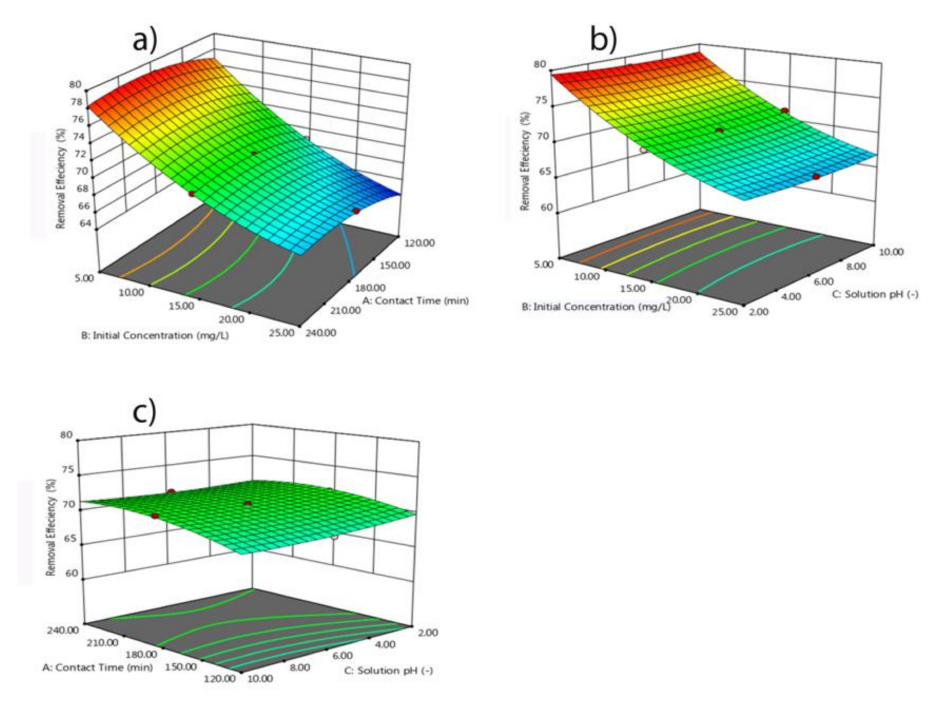
Figure 6. The combined e ff ect of ( a ) contact time and initial concentration, ( b ) contact time and pH, and ( c ) initial concentration and solution pH on % removal of